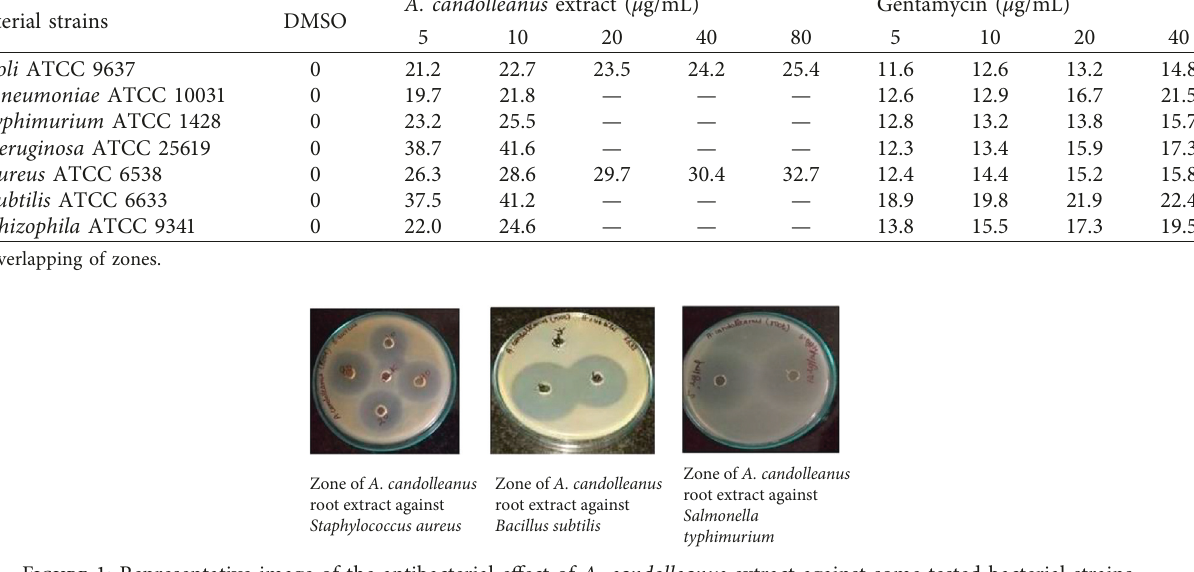
Table 2: Antibacterial activity of A. candolleanus root extract and standard gentamycin (diameter inhibition zone expressed in mm). Bacterial strains